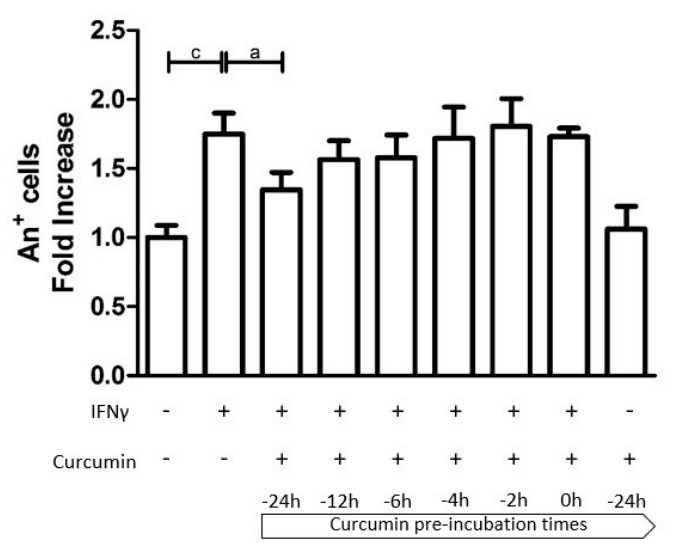
Figure 3. The effect of curcumin pre-treatment on HT29 apoptosis. The HT29 cell line was pre-incubated with curcumin at different time intervals and then stimulated with IFN γ for an additional 48 h. Programmed cell death is represented by Annexin V-positive cells (An+) expressed as a fold increase compared to untreated cells. Results are expressed as means ± SD of three independent experiments performed in duplicate. Data were analyzed with one-way ANOVA using the Bonferroni post-test (a: p < 0.05; c: p < 0.001).